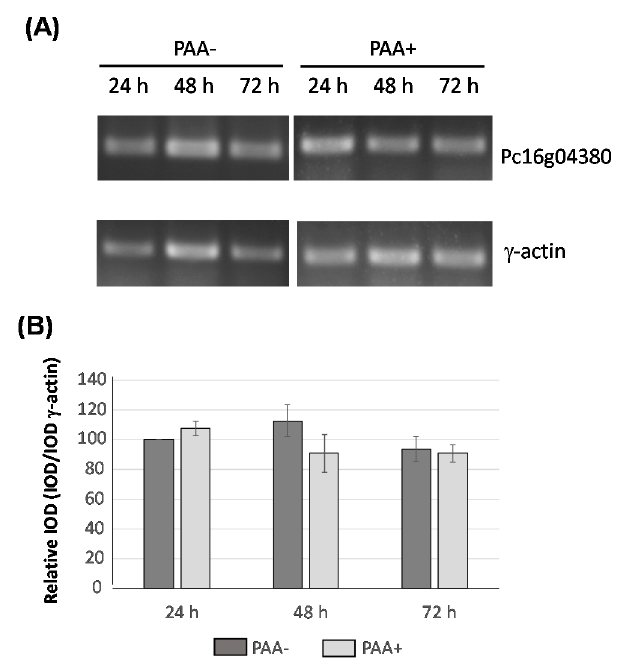
Figure 2. Transcriptional analysis of Pc16g04380 in the presence (PAA+) and absence (PAA-) of phenylacetic acid (PAA). ( A ) cDNA bands of Pc16g04380 and γ -actin were amplified by RT-PCR from RNA samples taken from cultures grown in complex medium during 24 h, 48 h and 72 h. ( B ) Integrated Optical Density (IOD) graph shows the expression profiles (normalized to the γ -actin expression levels) at 24 h, 48 h and 72 h. Those values corresponding to the expression of Pc16g04380 at 24 h were set to 100. Densitometry values correspond to the mean plus standard deviation of three independent measurements.